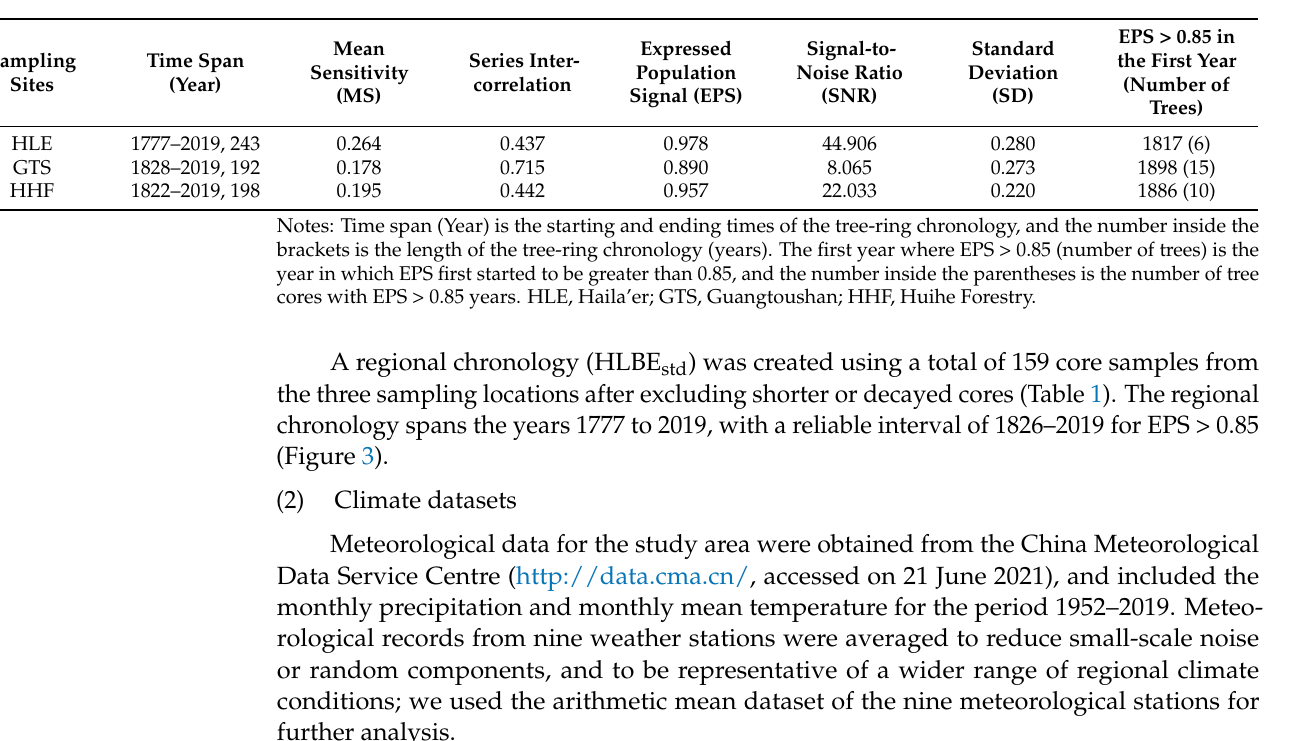
Table 2. Basic information on the chronology of Pinus sylvestris var. mongolica Litv. tree rings at three locations.